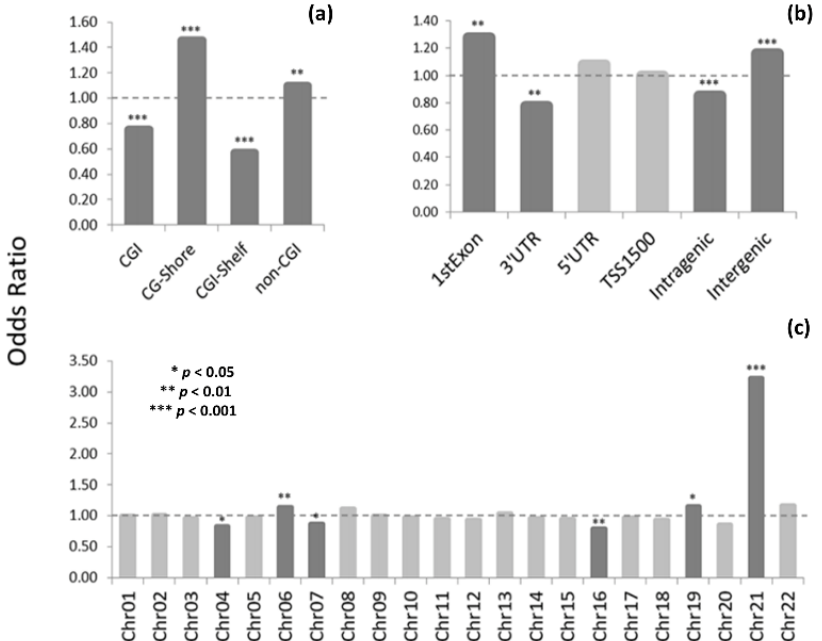
Figure 2. Plots depicting a comparison of the genomic distributions of DMPs—in the context of their relation to CGIs ( a ), location within a gene region ( b ), and chromosomal localization ( c )—with the corresponding genomic distributions of the HME450 probes using the odds ratio (OR). The OR represents a difference between the observed frequency of a genomic region in the DMP set and the expected frequency of the region estimated based on the HME450 probe content. The OR significance levels estimated based on Fisher’s exact ratio test are marked by asterisks.